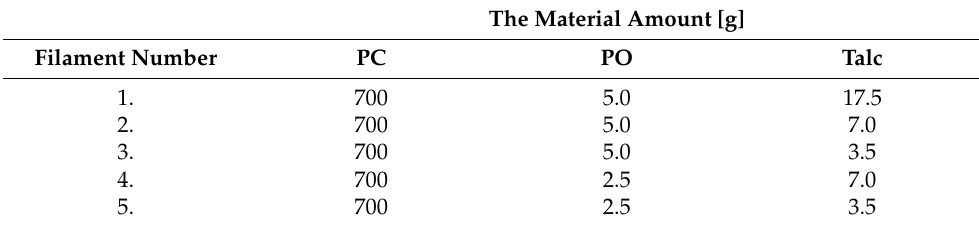
Table 1. Composition of the tested filaments.